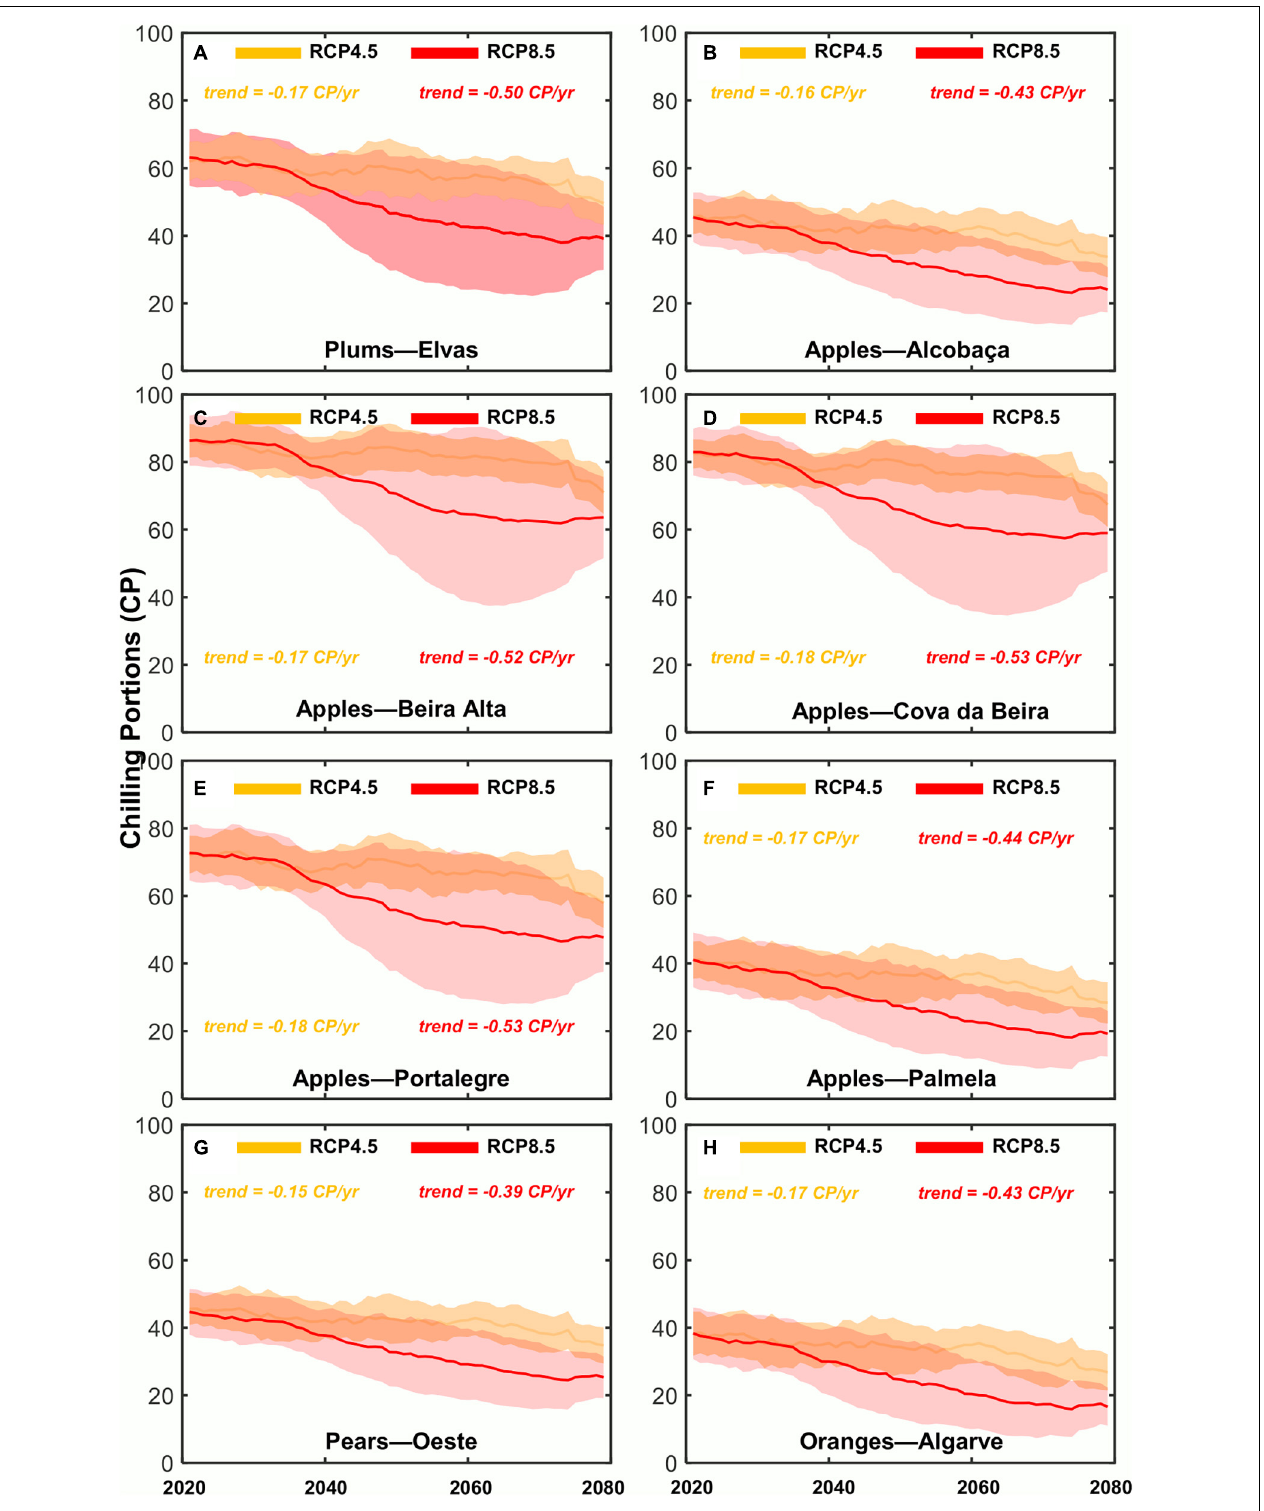
FIGURE 4 | Chronograms (2020–2080) of the Chilling Portions (CP) index for the two future scenarios (RCP4.5 and RCP8.5) over the selected eight denominations of origin regions in mainland Portugal: (A) Plums—Elvas; (B) apples—Alcobaça; (C) apples—Beira Alta; (D) apples—Cova da Beira; (E) apples—Portalegre; (F) apples—Palmela; (G) pears—Rocha do Oeste; (H) oranges—Algarve. Thick lines represent the climate model ensemble means of each RCP as a function of time, while shaded areas represent the corresponding climate model standard deviations.